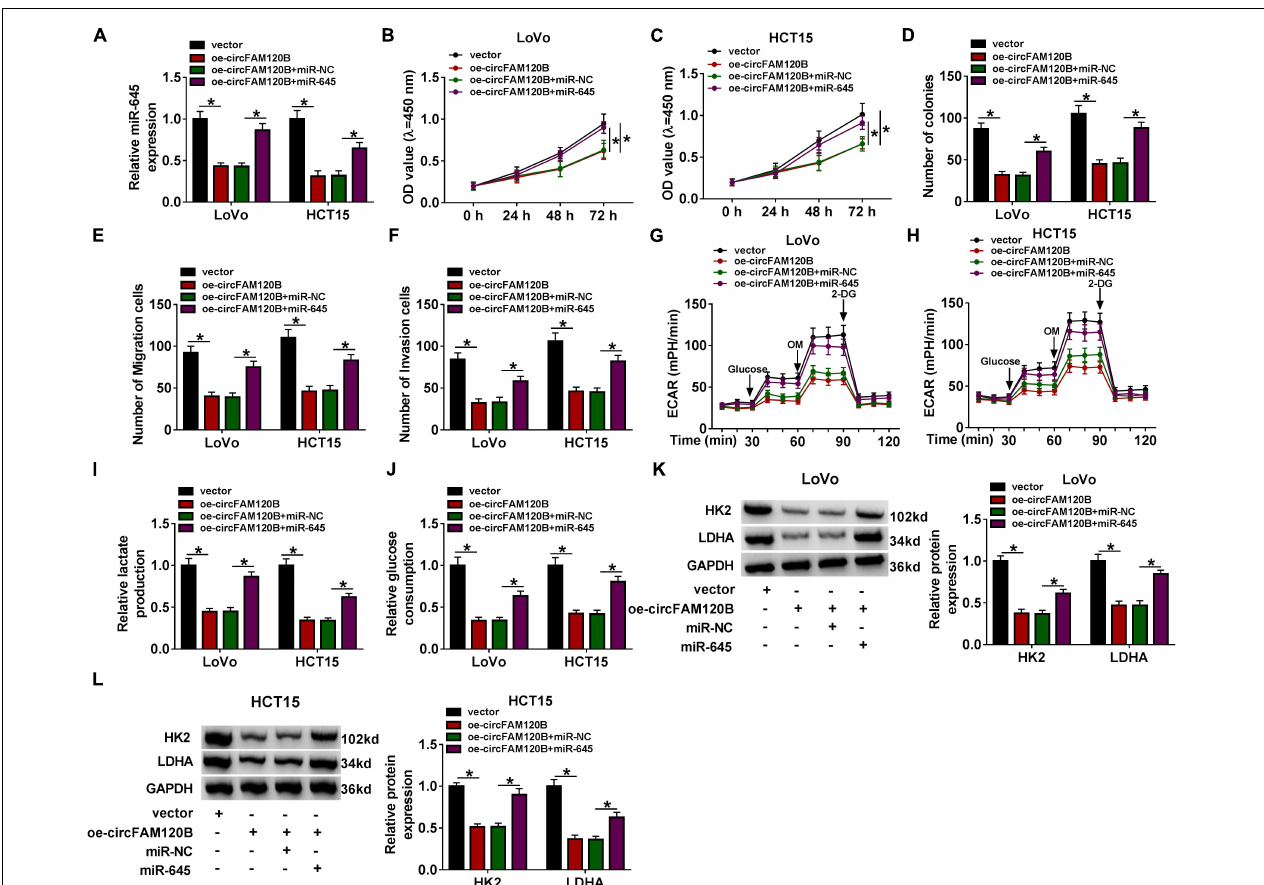
FIGURE 4 | CircFAM120B blocked CRC progression in vitro by targeting miR-645. LoVo and HCT15 cells were transfected with oe-circFAM120B alone or oe-circFAM120B + miR-645, with vector or oe-circFAM120B + miR-NC as a control. (A) The expression of miR-645 in these transfected cells was detected by qRT-PCR. (B,C) Cell proliferation was assessed by CCK-8 assay. (D) Cell proliferation was assessed by colony formation assay. (E,F) Cell migration and invasion were monitored by transwell assay (magnification: 100 × ). (G,H) Glycolysis was evaluated by ECAR using glycolysis stress test. (I,J) Lactate production and glucose consumption were quantified to monitor glycolysis. (K,L) The expression of HK2 and LDHA was quantified by western blot. * P < 0.05.